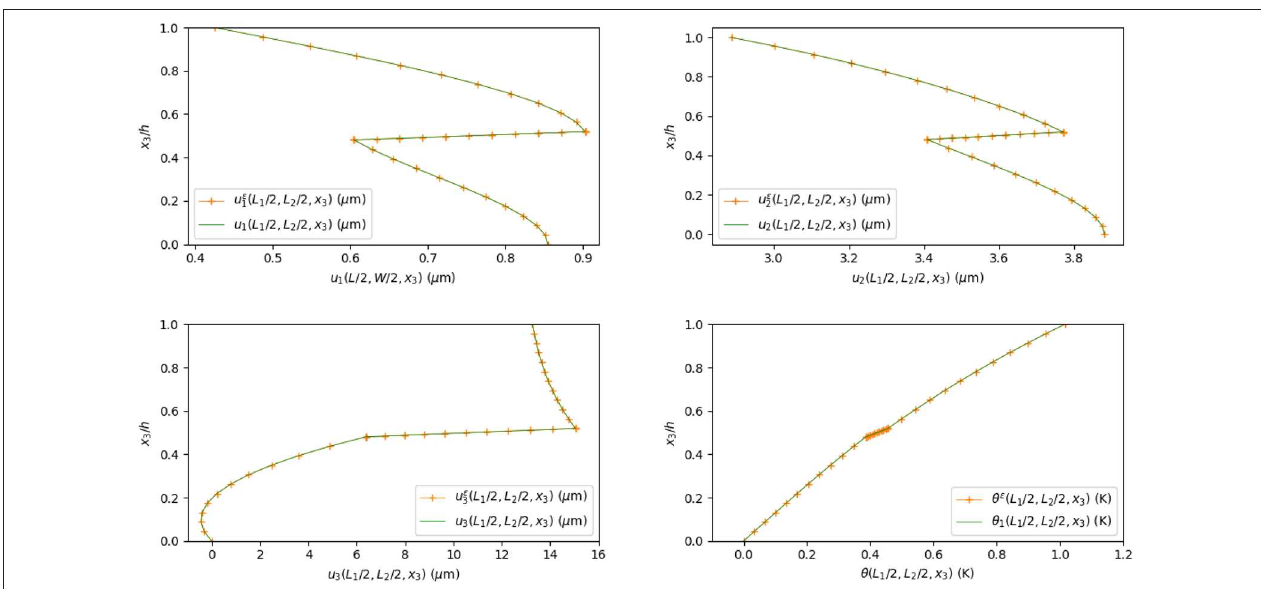
FIGURE 15 | Displacement field and temperature on a section along the x 3 axis, with ε/ h = 0.04.